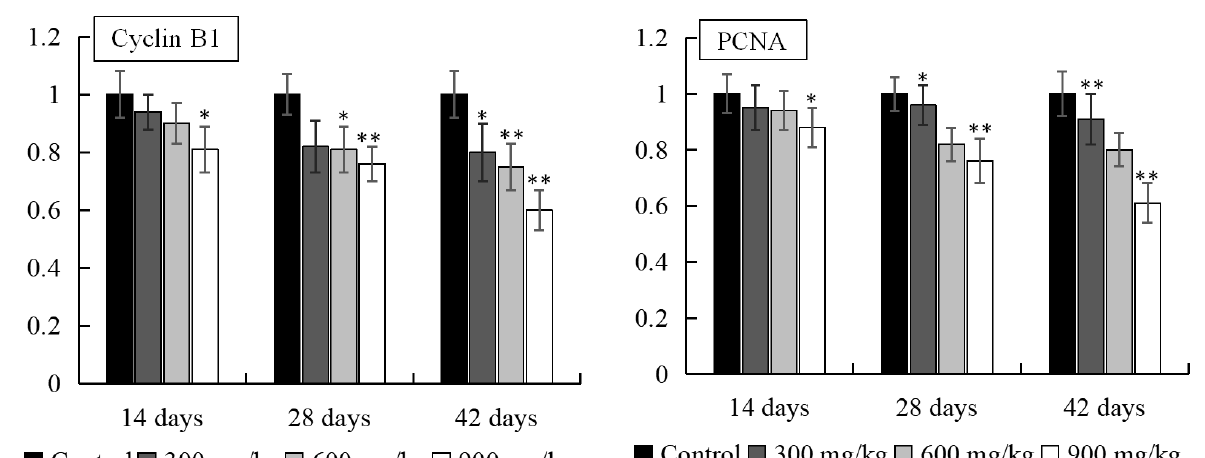
Figure 4. Changes of p53, p21, cyclin B and PCNA mRNA expression levels in the cecal tonsil. Data are presented with the mean ± standard deviation (n=6) *P<0.05, compared with the control group **P<0.01, compared with the control